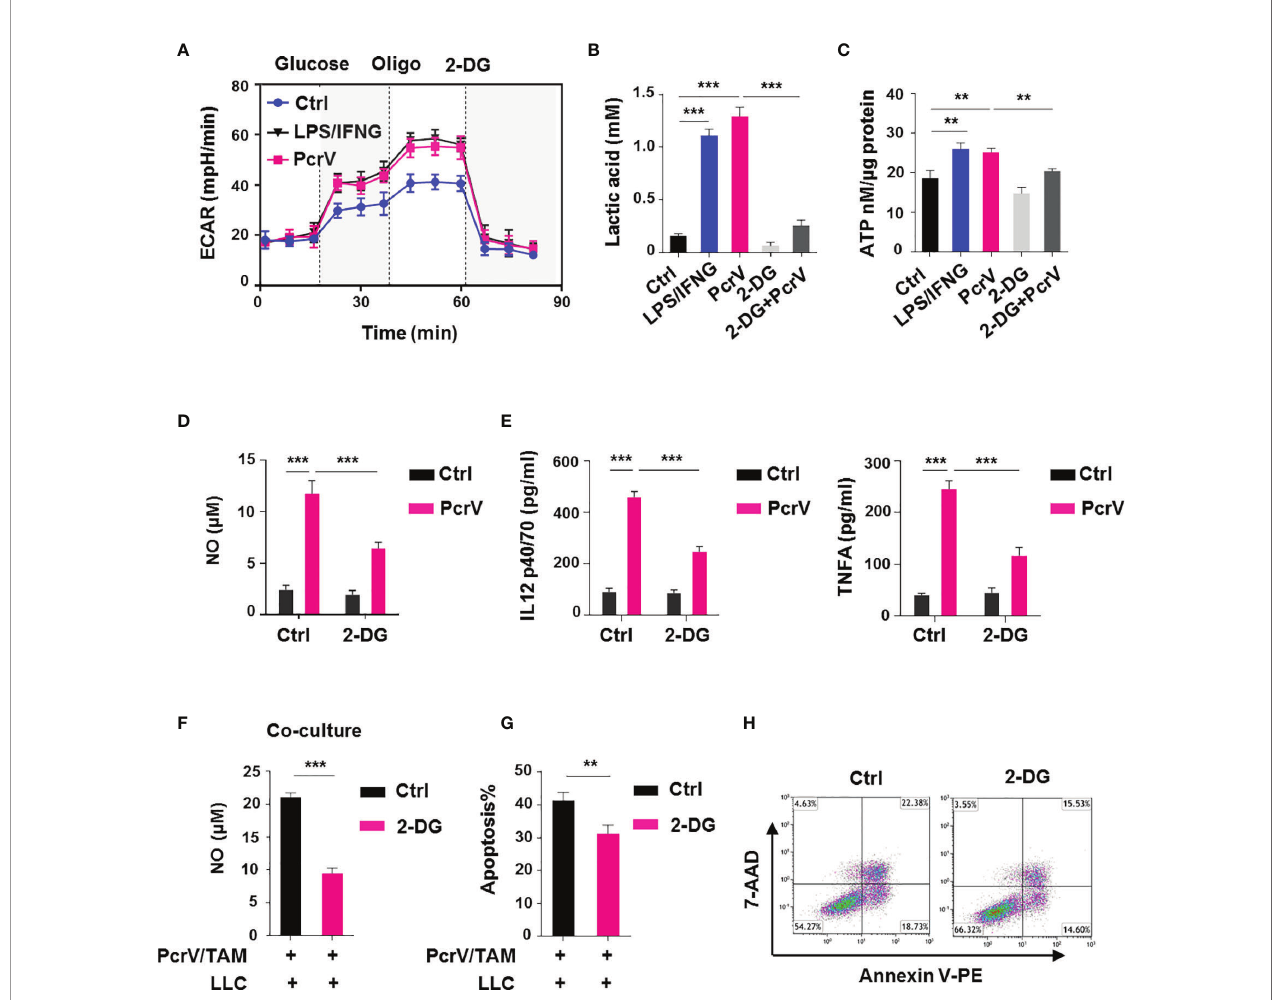
FIGURE 5 | PcrV-induced stimulation of glycolysis augments tumor-associated macrophage (TAM)-mediated tumoricidal activity. To induce TAMs in vitro , bone marrow-derived macrophages (BMDMs) were cultured in 10% FBS/DMEM containing 20% ( v / v ) LLC cell culture supernatant for 24 h and then primed or not with PcrV (10 m g/ml) for another 24 h For the induction of an M1-like phenotype, TAMs were pulsed with LPS (10 ng/ml) and IFNG (10 ng/ml) for 24 h For the inhibition of glycolysis, TAMs were pretreated with 2-deoxy- D -glucose (2-DG; 2 mM) for 2 h followed by exposure to PcrV for another 24 h (A) Assay for the extracellular acidi fi cation rate (ECAR). (B) Measurement of the lactic acid level in the culture supernatant. (C) Assay for ATP levels in cell lysates. (D) The NO level in the culture supernatant was detected using Griess reagent. (E) IL12 p40/70 and TNFA levels in the culture supernatant were analyzed by ELISA. BMDMs pretreated with 2-DG (2 mM, 2 h) were primed with PcrV (10 m g/ml) for 24 h and then co-cultured with LLC cells for another 24 h (F) Detection of NO level in the culture medium. (G, H) The apoptosis of LLC cells was detected by FACS. Data were expressed as means ± SD and analyzed by unpaired Student ’ s t -test. ** p < 0.01 and *** p < 0.001. Oligo, oligomycin; FBS, fetal bovine serum; DMEM, Dulbecco ’ s modi fi ed Eagle ’ s medium; LLC, Lewis lung cancer; FACS, fl uorescence-activated cell